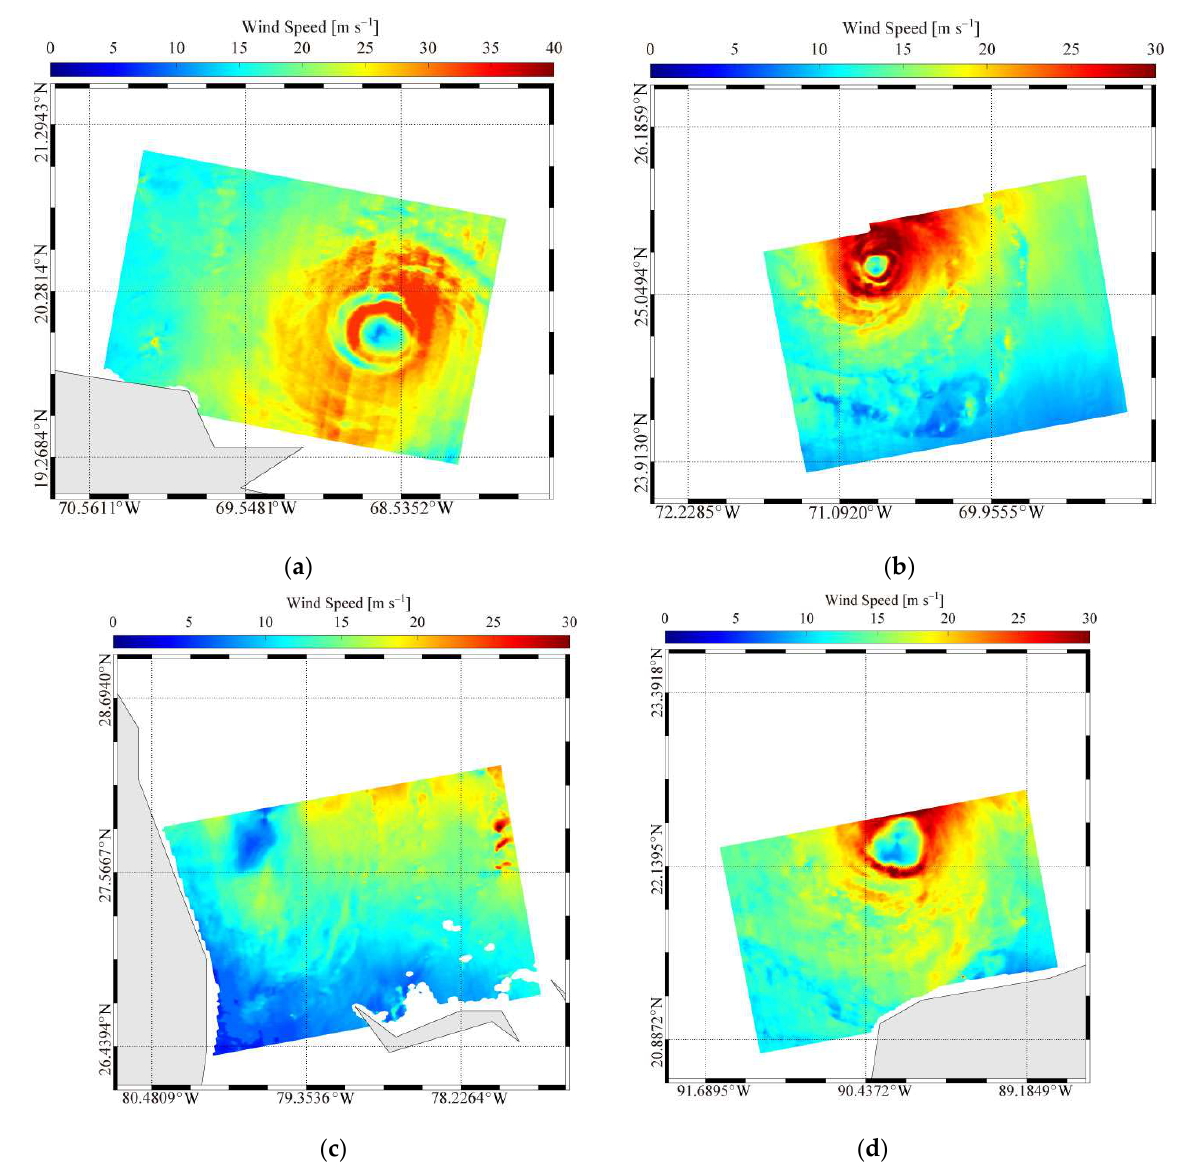
Figure 2. Inverted wind maps derived from of VV-polarized S-1 SAR images using the CMOD5.N geophysical model function (GMF). ( a d ) The SAR scenes shown in Figure 1a–d.